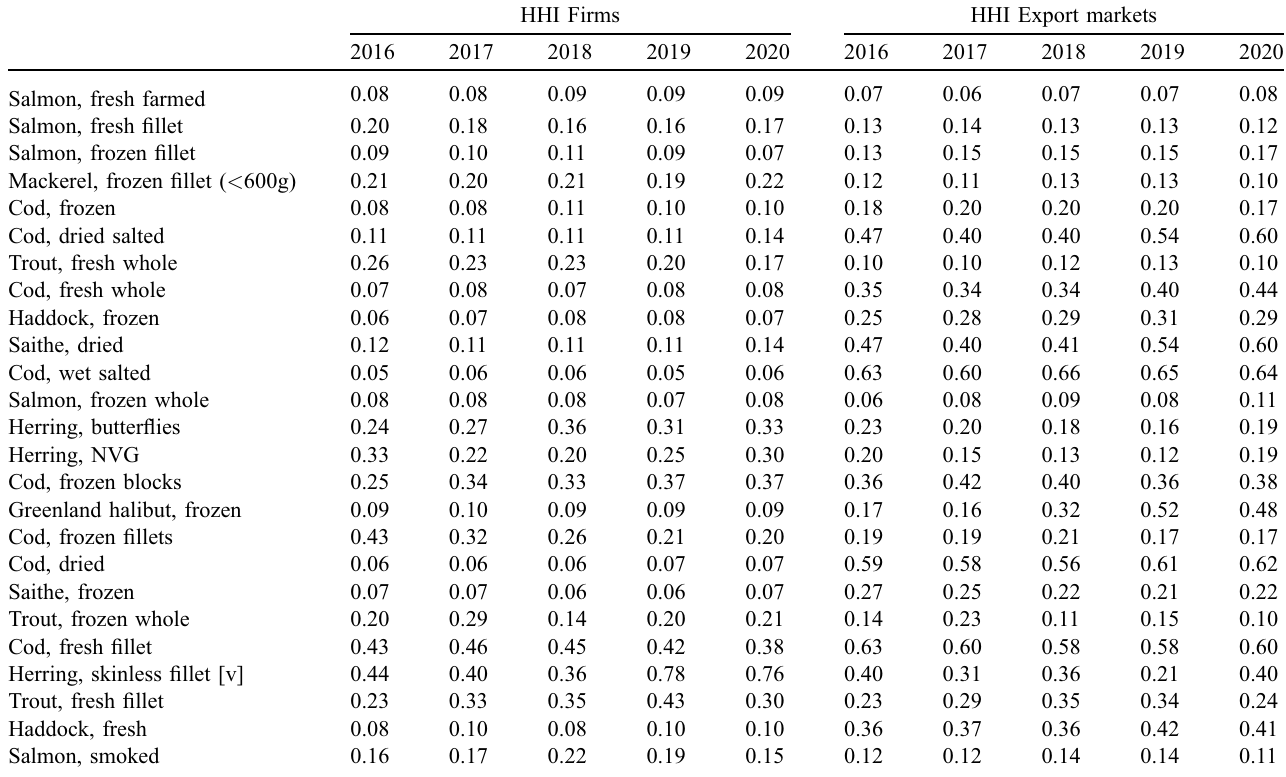
Table 3. Her fi ndahl index for fi rms and export markets by product 2016 –